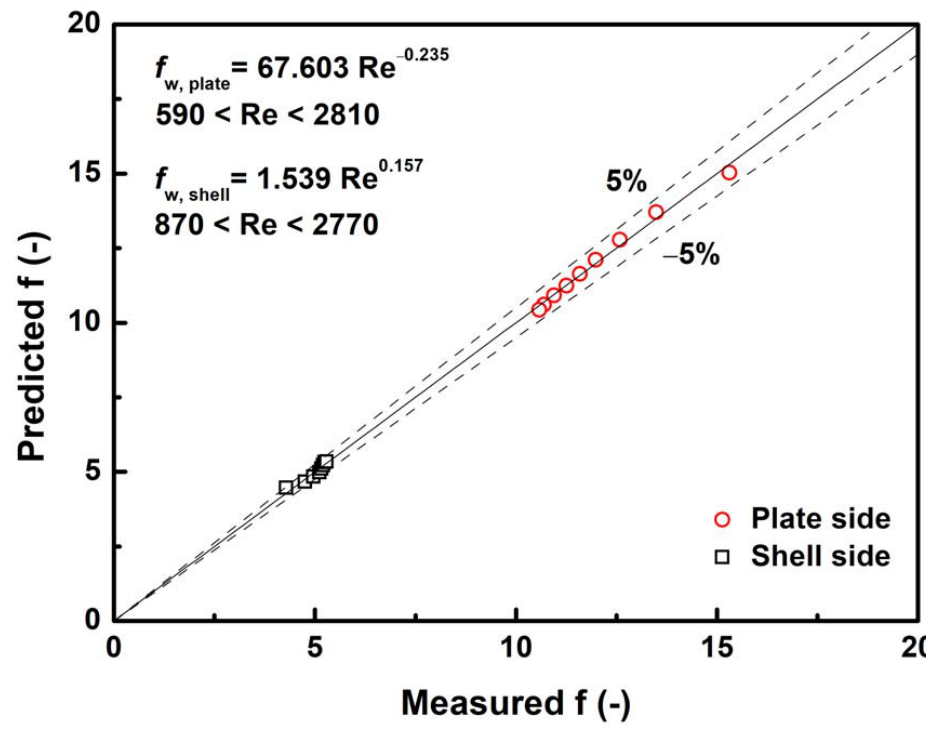
Figure 11. Comparison of the predicted with measured f in the PSHE.